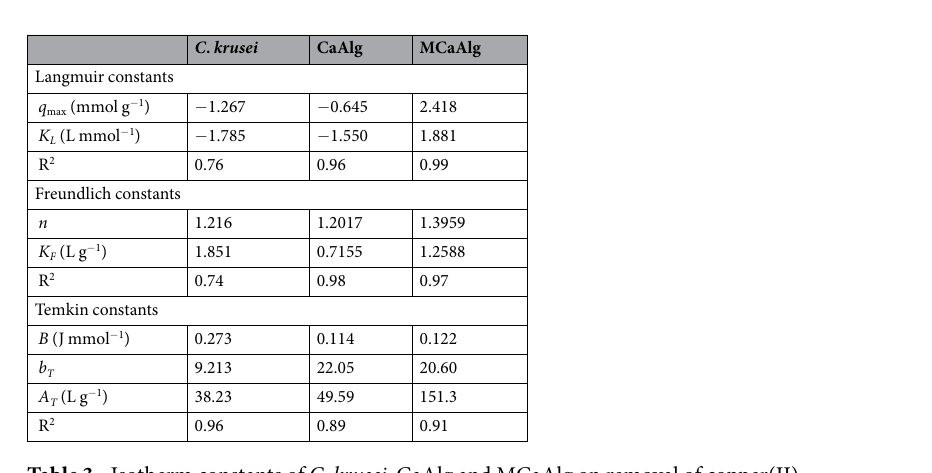
Table 3. Isotherm constants of C . krusei , CaAlg and MCaAlg on removal of